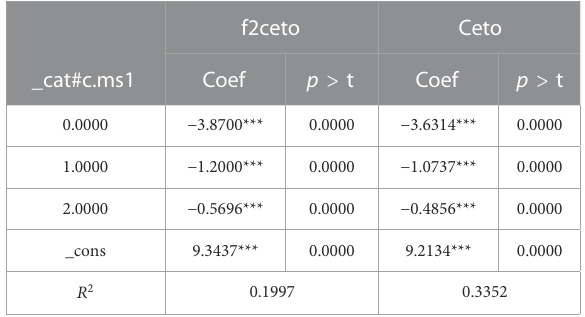
TABLE 7 Double threshold estimates. TABLE 8 Results of double threshold